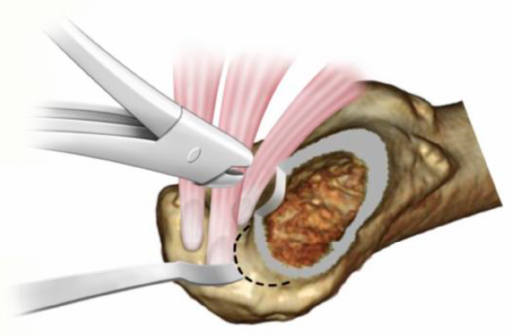
Figure 5. Osteotomy site at the femoral saddle. The conjoint tendon and Oe are identified under direct view and resect the bone in close proximity.